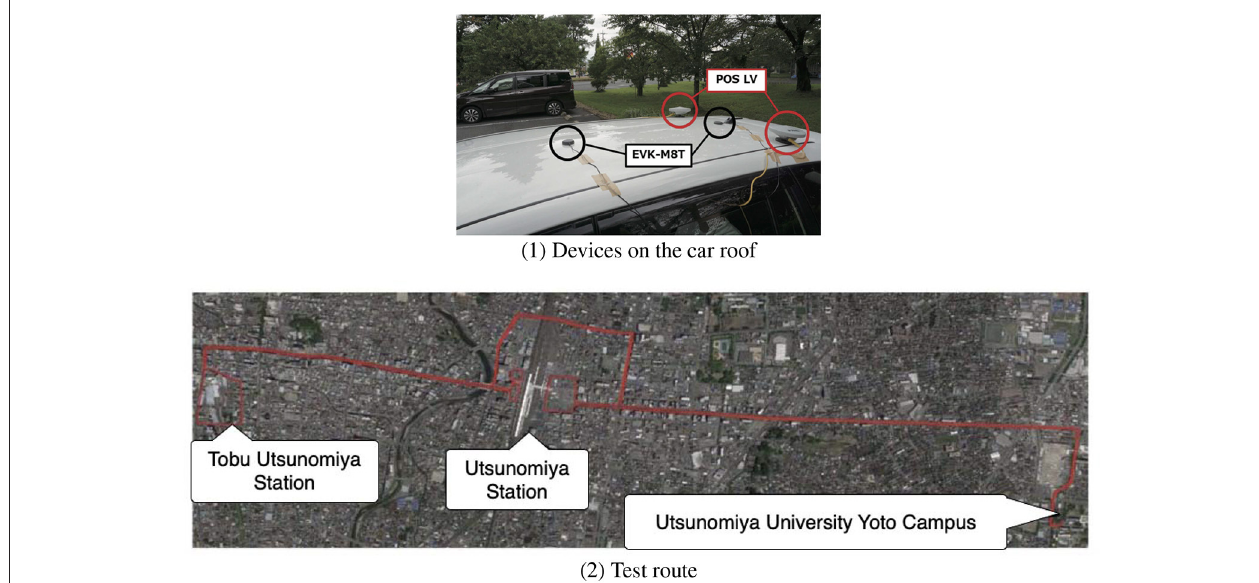
FIGURE 9 | Devices on the car roof and test route.